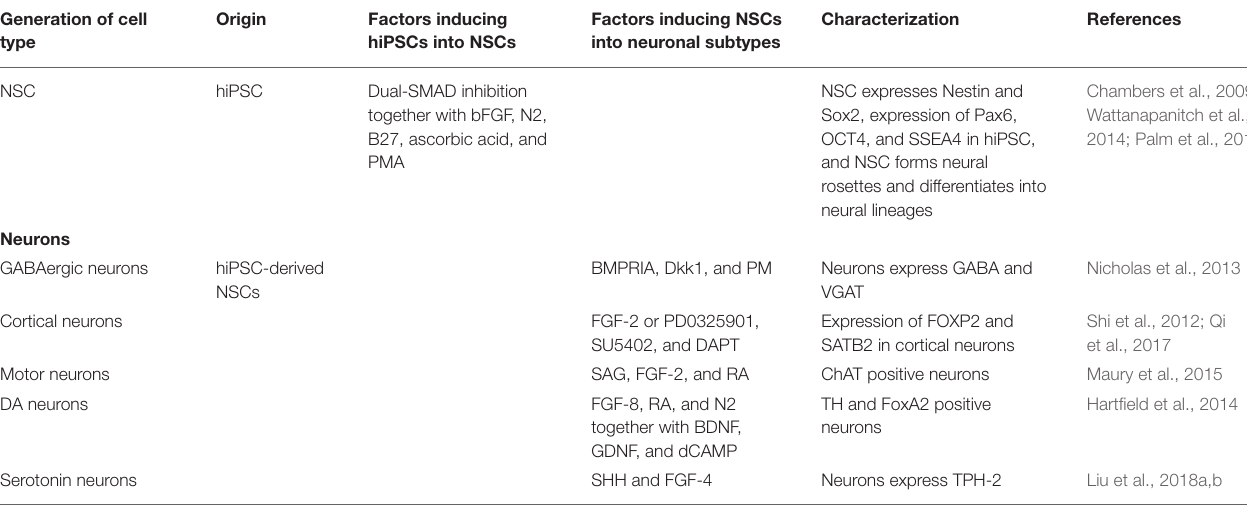
TABLE 1 | Differentiation of NSCs and neuronal subtypes from human iPSCs.